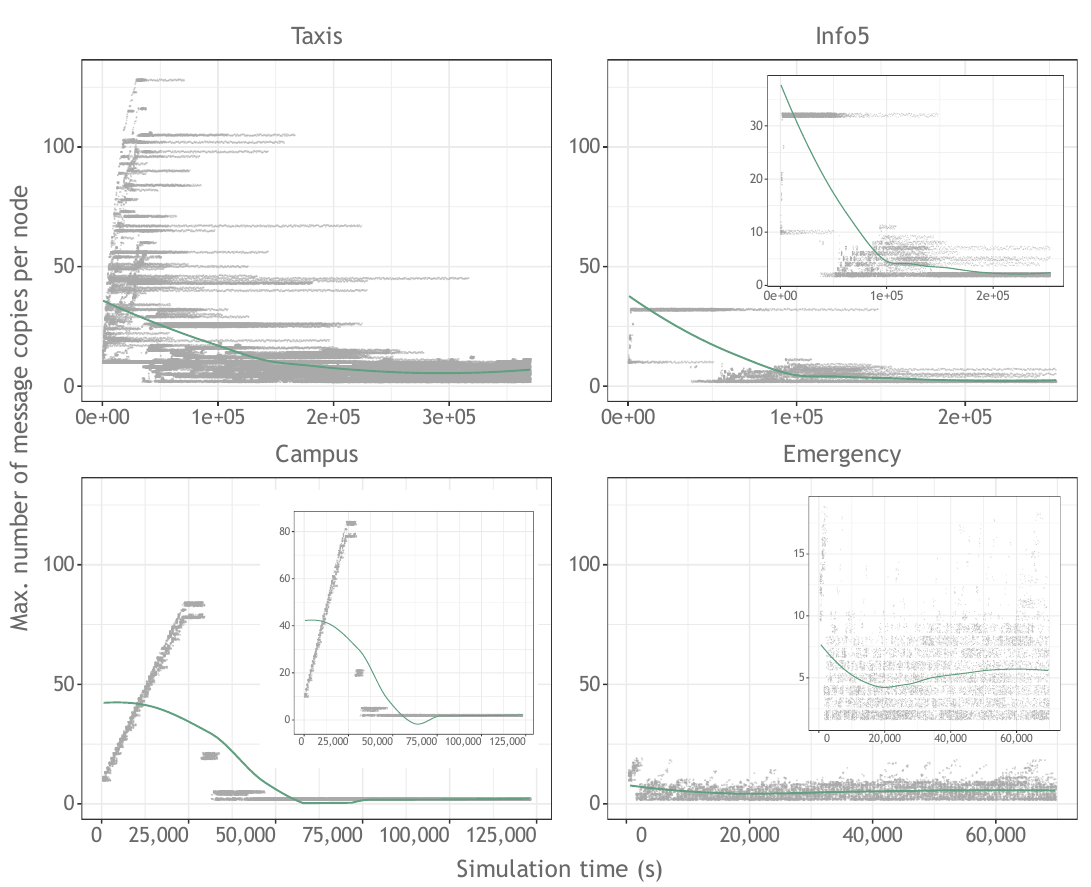
Figure 6. For the Control configuration, progression of the replication limit used by each node at each time unit when a new message is created. In blue, we show the tendency of the replication limit over time (for Taxis it is 8, for Info5 it is 2, for Campus it is 2, and for Emergency it is 4). For the scenarios Info5, Campus, and Emergency, a zoomed-in plot with a different scale has been embedded in the main